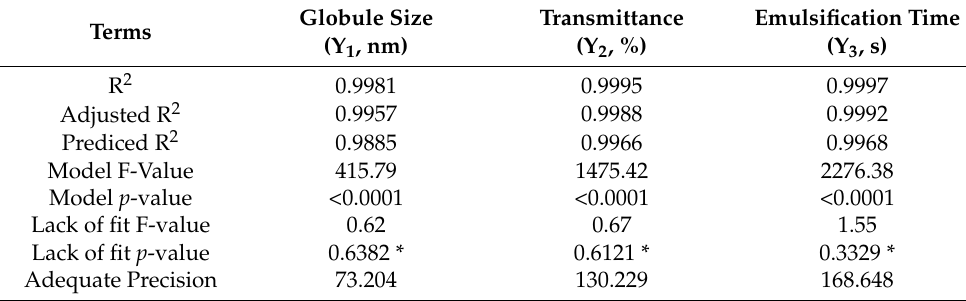
Table 3. Statistical summary for the best fit model shown by different selected